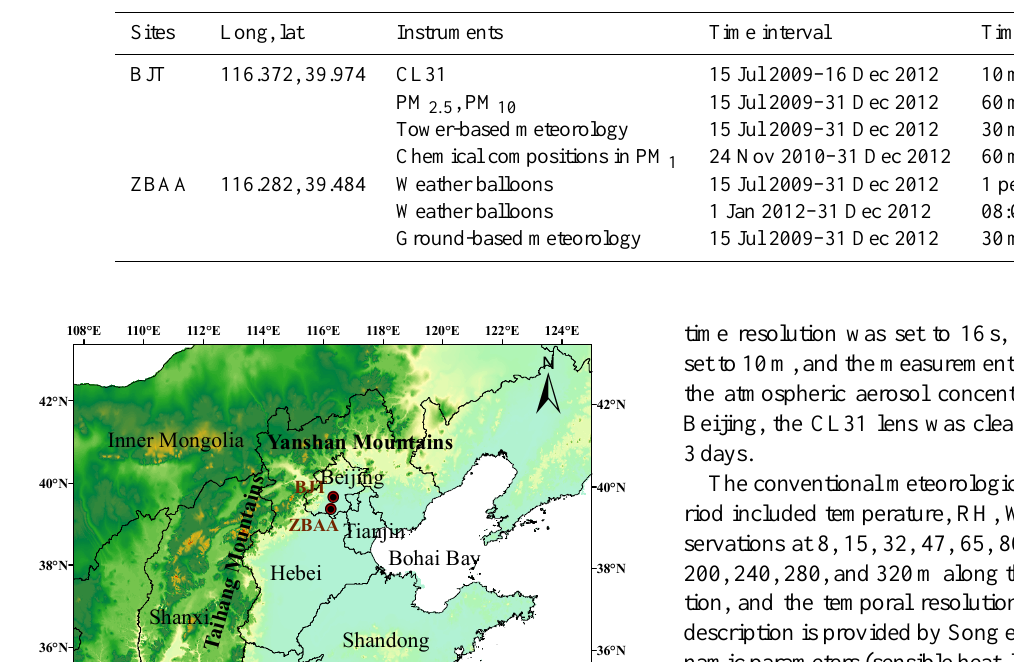
Table 1. Site description and instrument list. BJT refers to the Beijing tower; ZBAA is the international standard weather station.